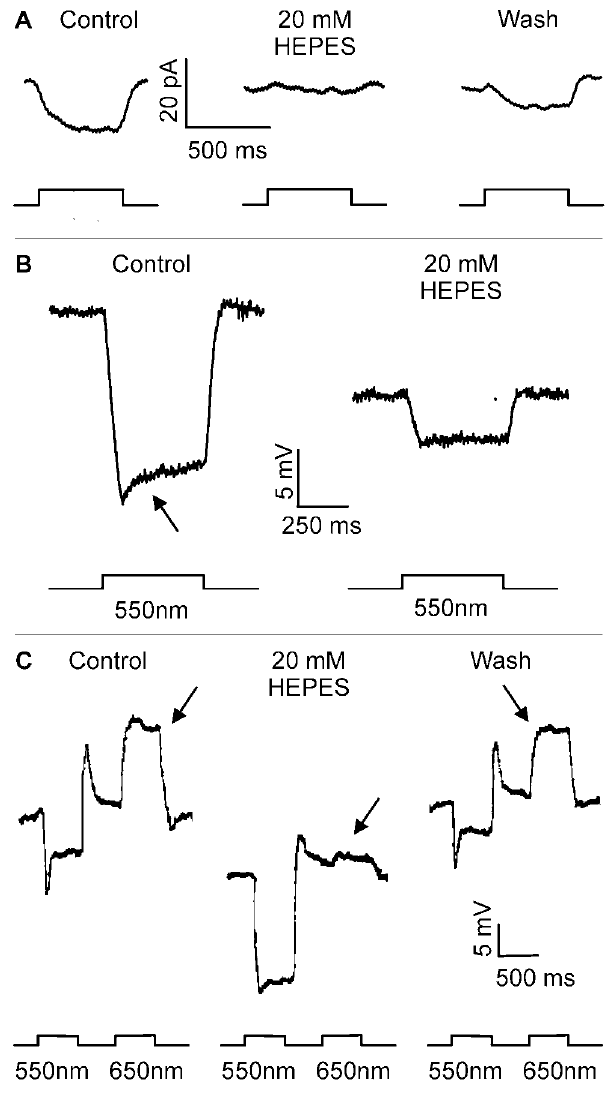
Figure 2. HEPES reduces feedback-mediated responses in the cone/horizontal cell network in the isolated retina of goldfish. A , Feedback responses elicited by a 500 ms full-field (3000 m m) stimulus (I=0 log) delivered in the presence of a 20 m m spot of light (I=0 log) centered on a cone voltage-clamped at 2 45 mV. Current responses are shown in control (left), in the presence of 20 mM HEPES (middle), and after washout (right). HEPES reduces the amplitude of the feedback- mediated responses. B , Responses of a monophasic horizontal cell to 550 nm light (I=1 log) in control (left), and after application of 20 mM HEPES (right). HEPES hyperpolarizes horizontal cells and strongly reduces the light-induced hyperpolarization and the feedback-induced roll-back response (arrow). C , Responses of a biphasic horizontal cell to light of 550 nm (I=1 log) and 650 nm (I=1 log) in control (left), after application of 20 mM HEPES (middle), and after washout (right). HEPES reduces the feedback-induced depolarizing response due to deep red light stimulation